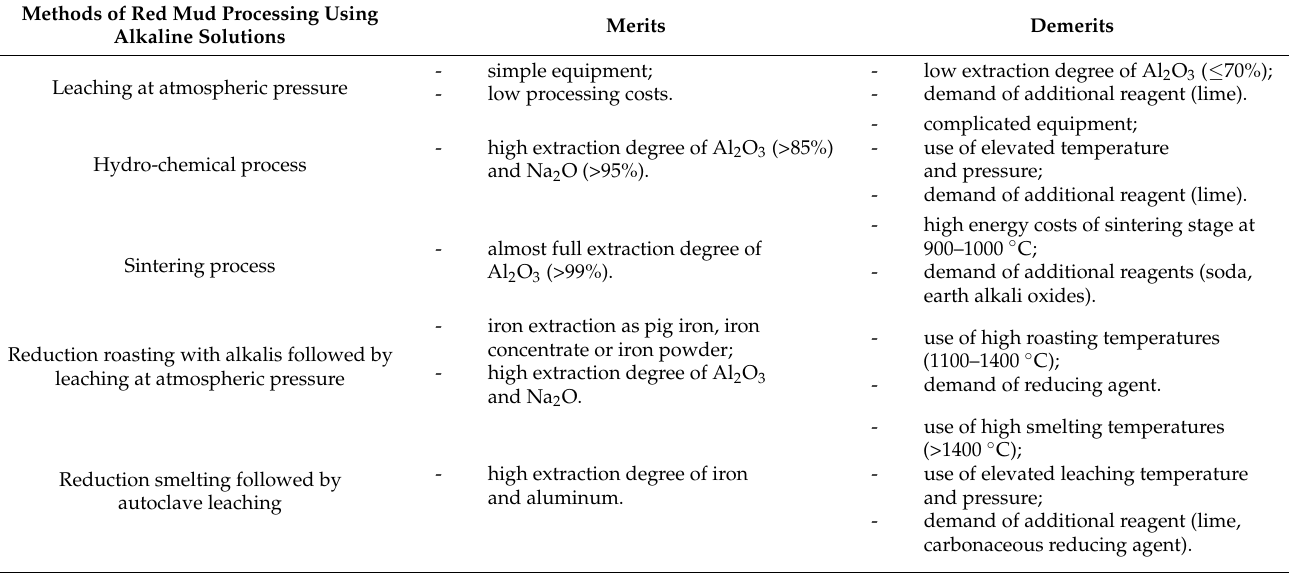
Table 1. Methods of red mud processing using alkaline